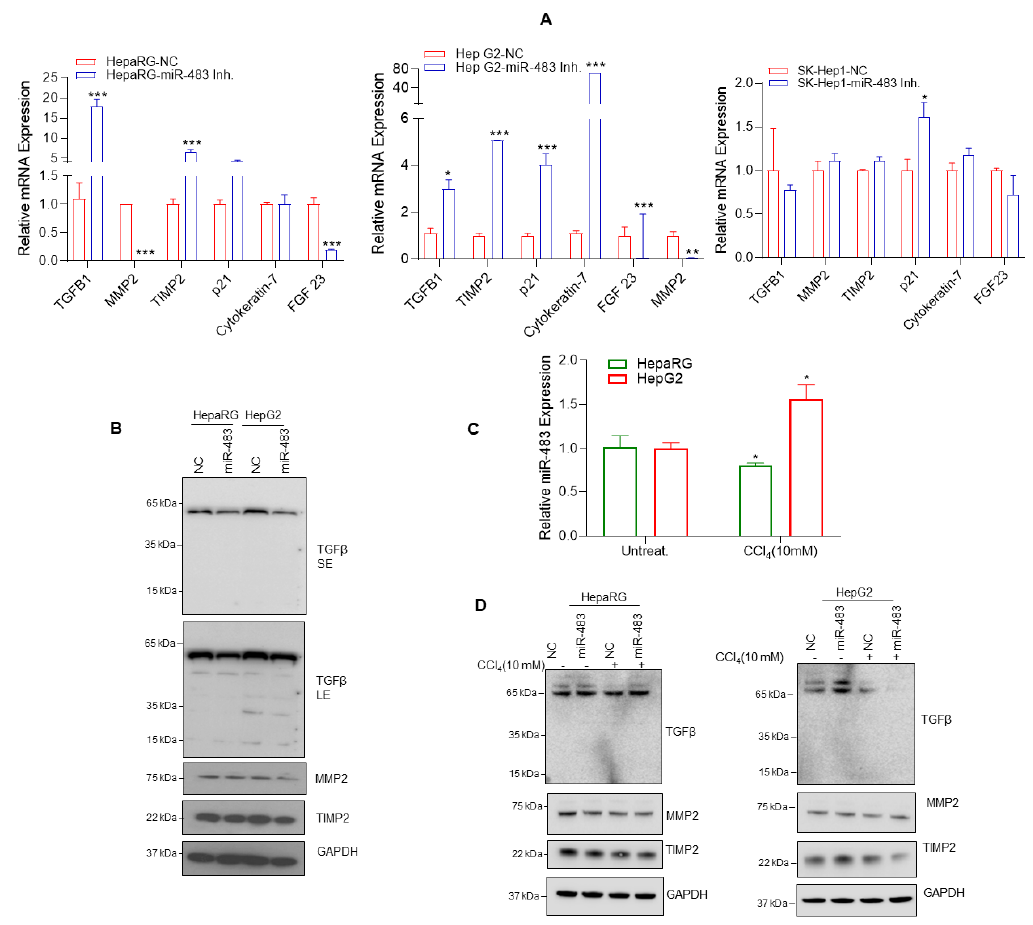
Figure 5. miR-483 modulates fibrosis. ( A ) HepaRG and HCC cells were transfected with NC, or miR-483 inhibitor for 30 h, and the expression of key genes related to the fibrogenic signaling such as TIMP2 , MMP2 , TGF- β , Cytokeratin-7 , p21, and FGF-23 were analyzed by RT/qPCR (all panels). * p < 0.05, ** p < 0.01, *** p < 0.001 compared with NC transfected cells. ( B ) HepaRG and HepG2 cells were transfected with NC or miR-483 as indicated for 30 h, and the expression of TGF β , TIMP2, MMP2, and GAPDH was analyzed by immunoblotting. ( C ) HepaRG and HepG2 cells were treated with vehicle or CCl 4 as indicated for 72 h, and expression of miR ‐ 483 was analyzed by RT/qPCR. * p < 0.05 compared with NC ‐ transfected cells. ( D ) HepaRG and HCC cells were transfected with NC or miR ‐ 483 inhibitor and treated with CCl 4 as indicated for 72 h; the expression of TGF β , TIMP2, MMP2, and GAPDH was analyzed by immunoblotting. The uncropped blots are shown in Supplementary Materials.